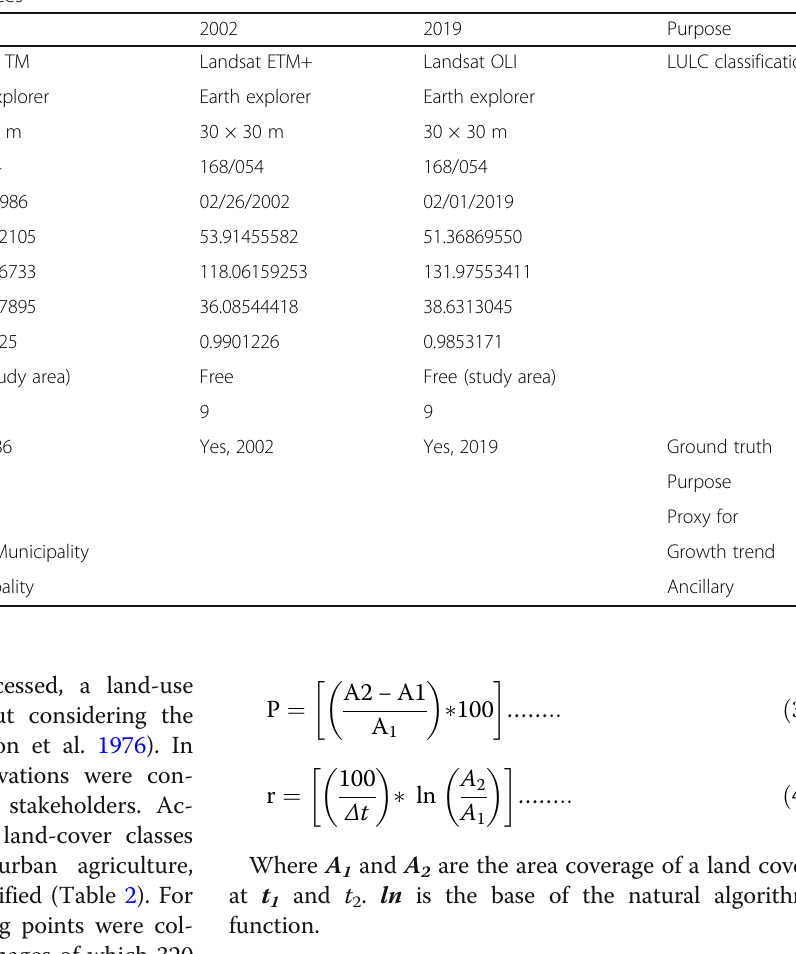
Table 1 Description of data type and